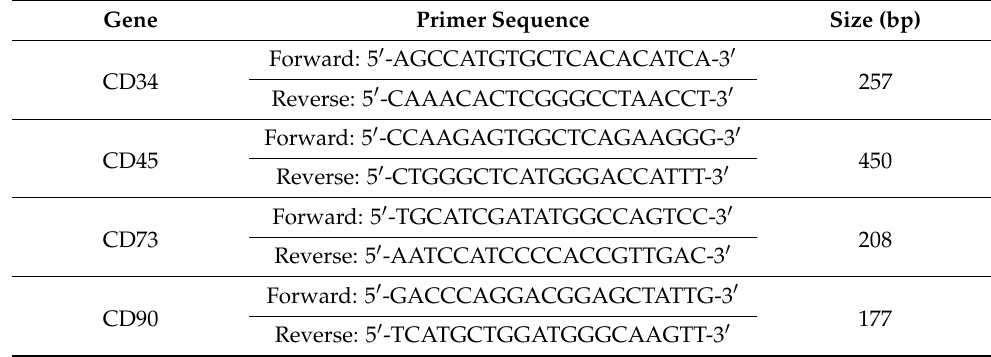
Table 1. The described CD73, CD90, CD34, and CD45 sequences. Gene Primer Sequence Size (bp)